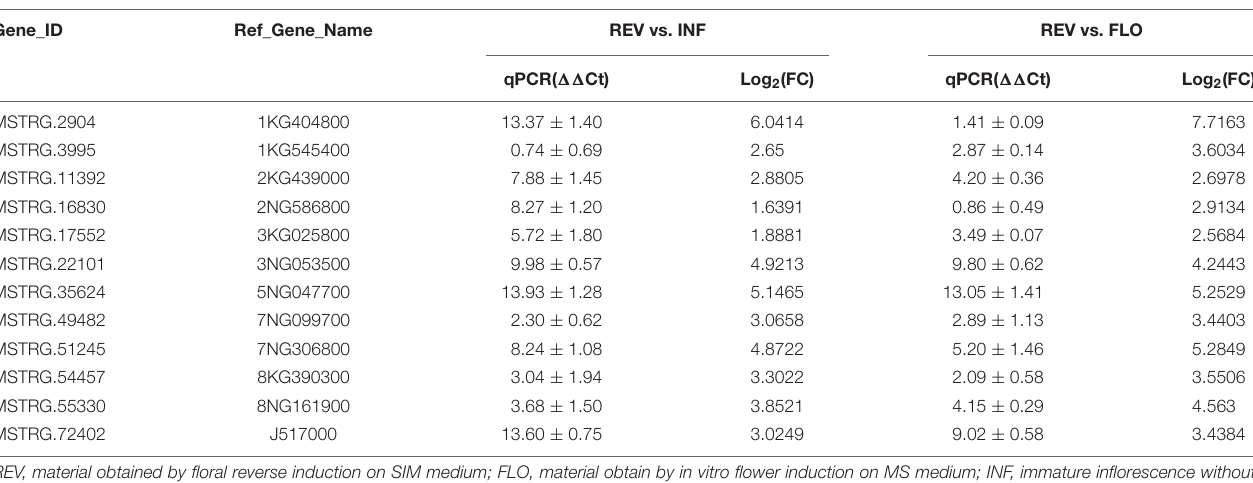
TABLE 2 | Real-time RT-PCR analysis of 12